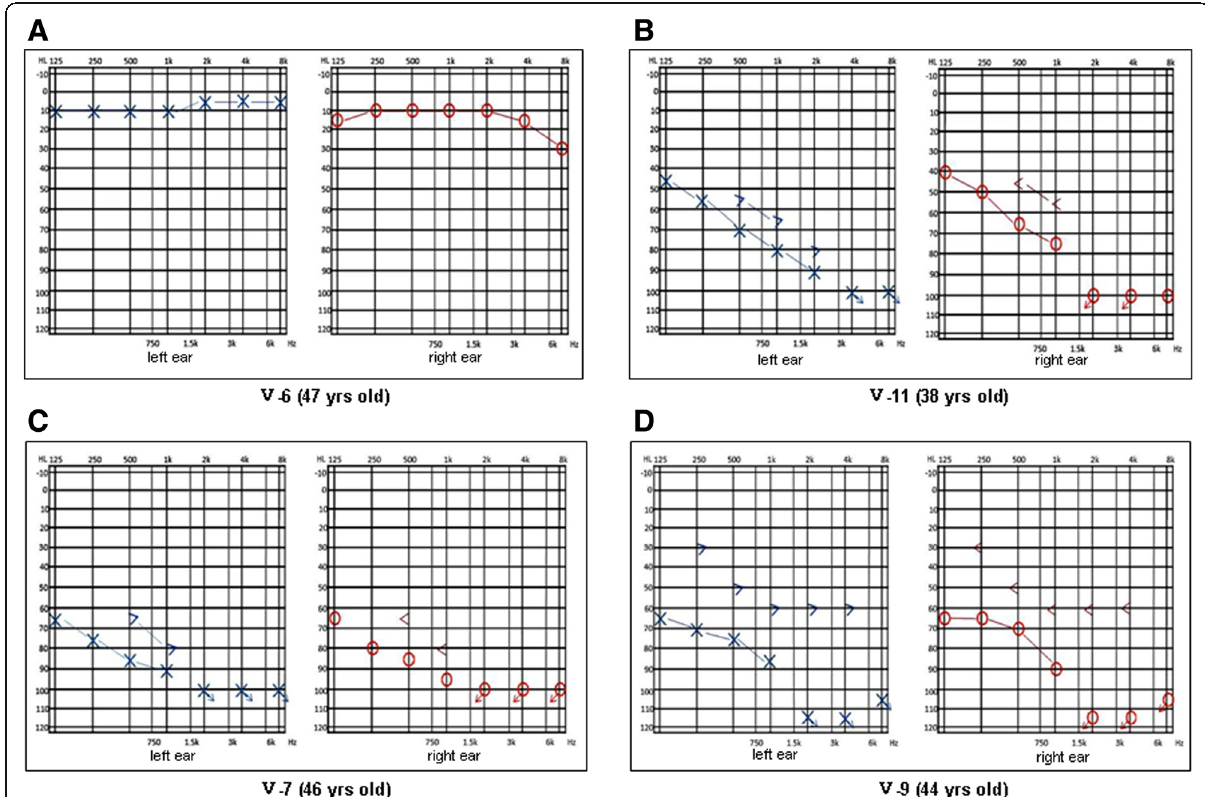
Fig. 2 Pure tone audiometry of representative subjects. Both the left (blue symbol Χ , >, ↘ ) and right (red symbol Ο , <, ↙ ) ears of subjects were tested for their response to frequency (Hz, X-axis) and intensity (dB, Y-axis). Χ and Ο denote gas conduction; >and < denote bone conduction; ↘ and ↙ denote no response; Audiograms of three different patients (V-7, V-9, V-11) are shown in b , c , d respectively and normal member (V-6) is shown in a . The sensorineural hearing loss ranges from mild (V-11), to moderate (V-9), and to severe